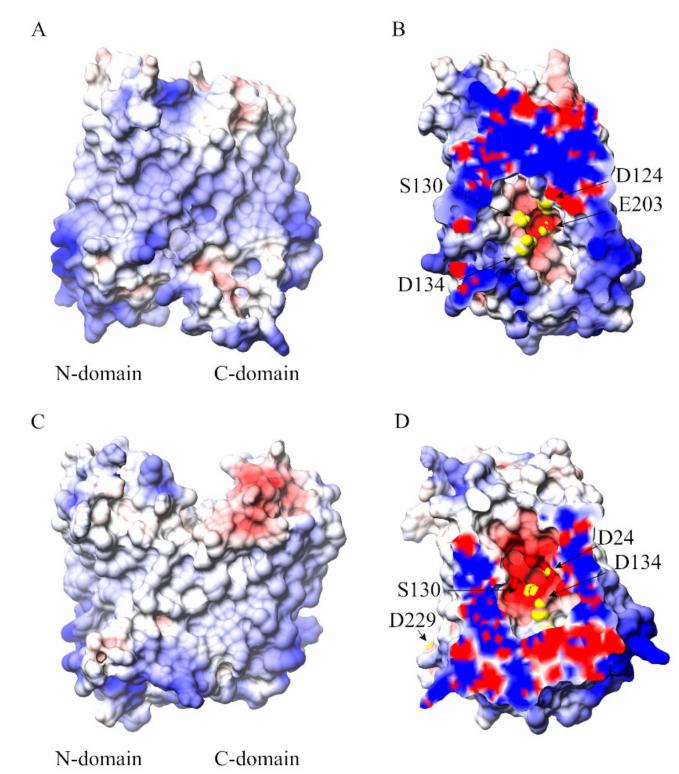
Figure 7. ( A ) View along the membrane plane of the overall structure of the inward-facing BdFpn structure, and ( B ) close-up of the negatively charged pocket turned by 90 degrees with respect to panel